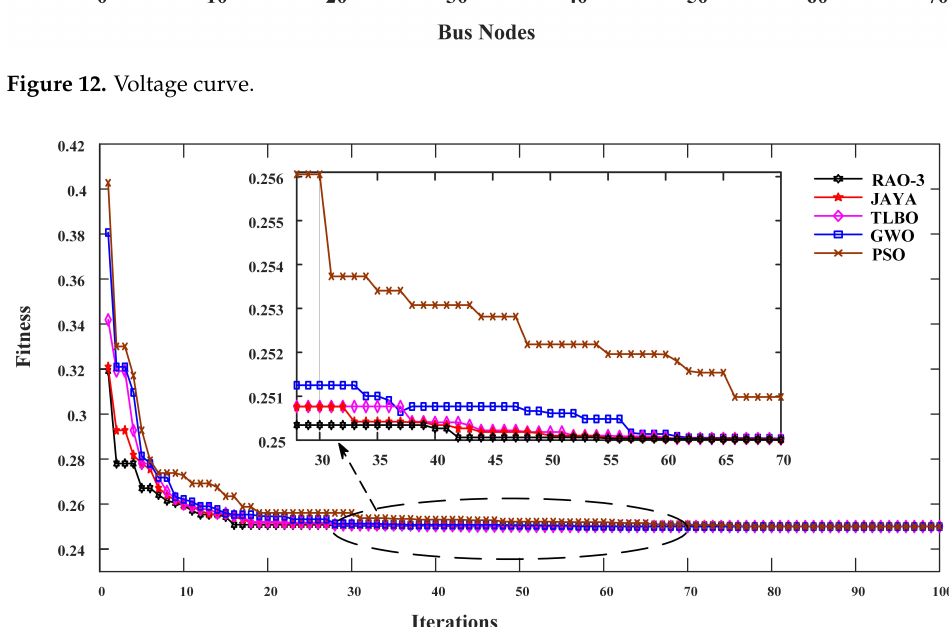
Figure 13. Fitness